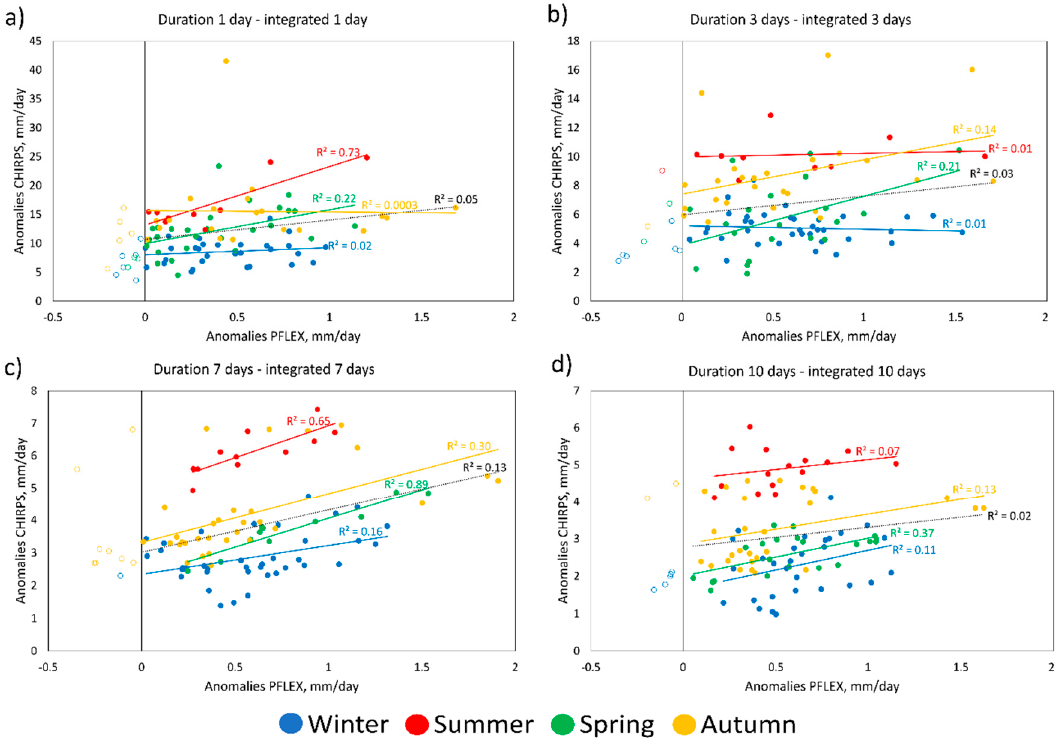
Figure 3. Scatterplot for moisture supply anomalies from Mediterranean Sea (PFLEX- ANOM ) ( x -axe, mm/day) and precipitation anomalies from CHIRPS database (Anomalies CHIRPS, y -axe, mm/days) over the Danube River Basin for 100 ranked extreme precipitation events separated on seasonal scales (winter—blue circles; summer—red circles; spring—green circles; autumn—yellow circles). The filled circles represent events with positive PFLEX- ANOM values and empty circles represent negative values. The corresponding regression line and coefficient of determination (R 2 ) are also shown for each season (blue, red, green, and yellow lines) and on an annual scale (dashed black line) for events with positive PFLEX- ANOM values.